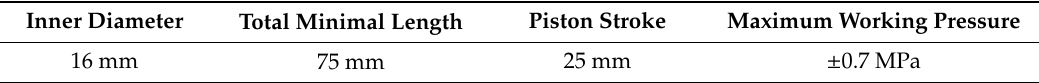
Table 1. Cylinder performance parameters.